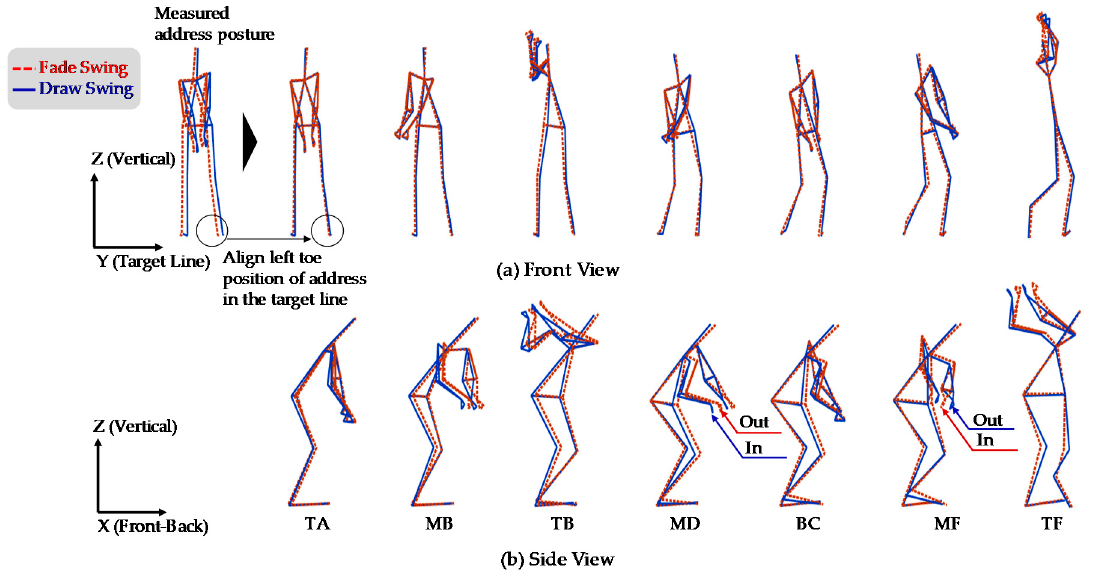
Figure 3. Representative trials of fade swing (red lines) and draw swing (blue lines): ( a ) front view, ( b ) side